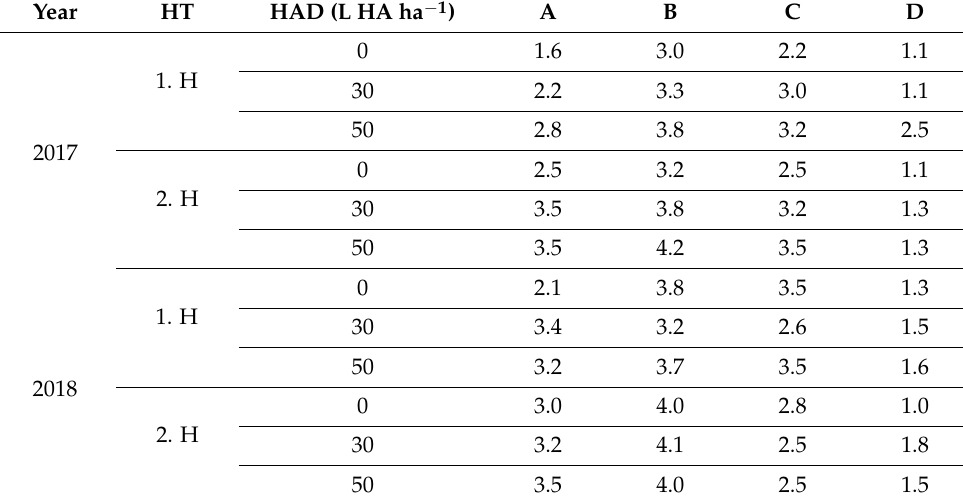
Table 4. Antimicrobial activity of O. vulgare subsp. hirtum L. according to HT and HAD in 2017 and 2018.